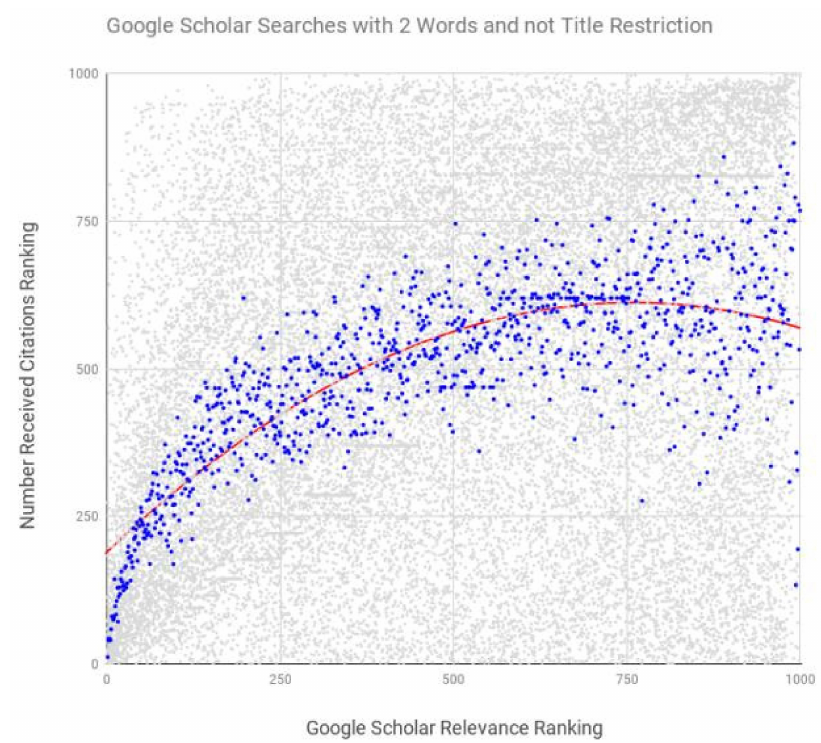
Figure 2. Google Scholar Searches with Two Words and No Title Restriction (rho 0.721, median in blue, the rest of data in